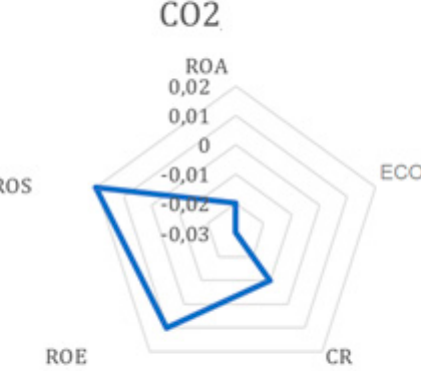
Scheme 1. Results of variable rank correlation for 2021. Based on own research according to CRAN [32,33].